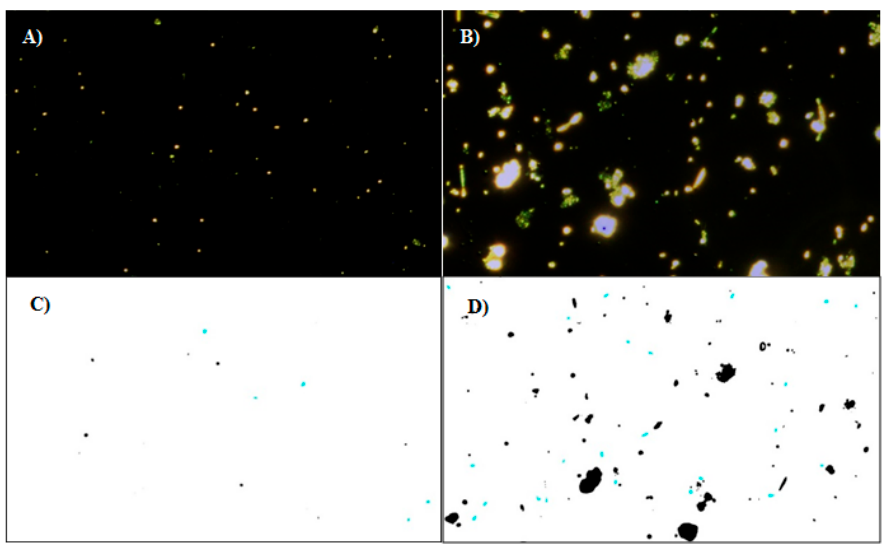
Figure 7. Bioassay performed on the field water sample filtered with a membrane with ( A ) 5 µ m pores and ( B ) 20 µ m pores. ( C , D ) Visual demonstration of bacteria screening using shape and area factors. The images corresponding to the set parameters appear in blue. The image represents the DF data obtained with a field sample and treated using ImageJ software.